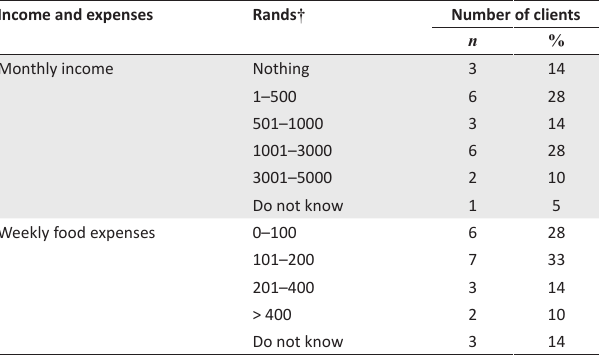
TABLE 2: Income and food expenses per household. Income and